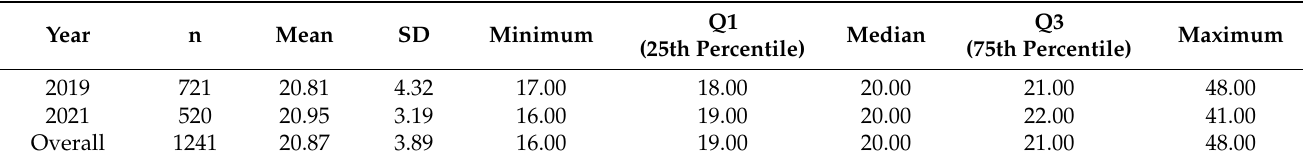
Table 2. Demographics of the 2019 and 2021 samples.